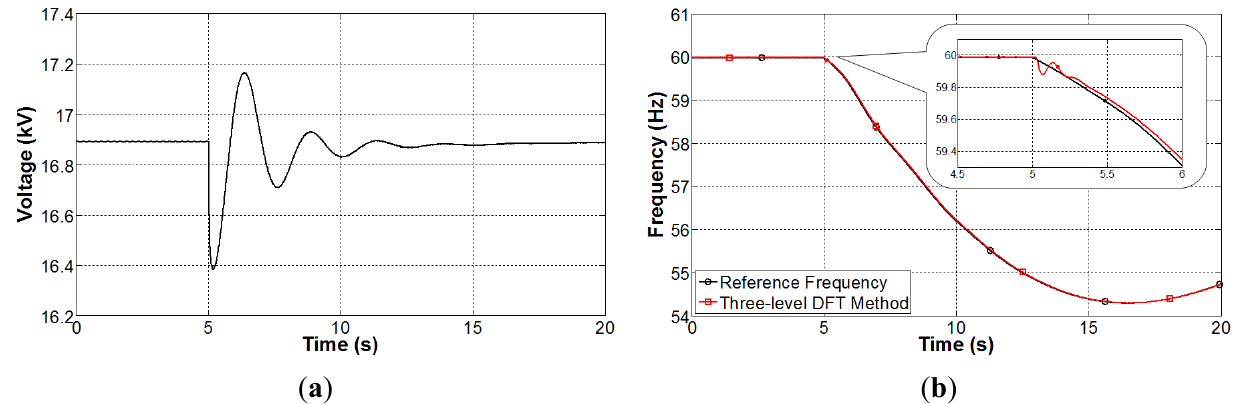
Figure 9. Modified IEEE 5-bus system.